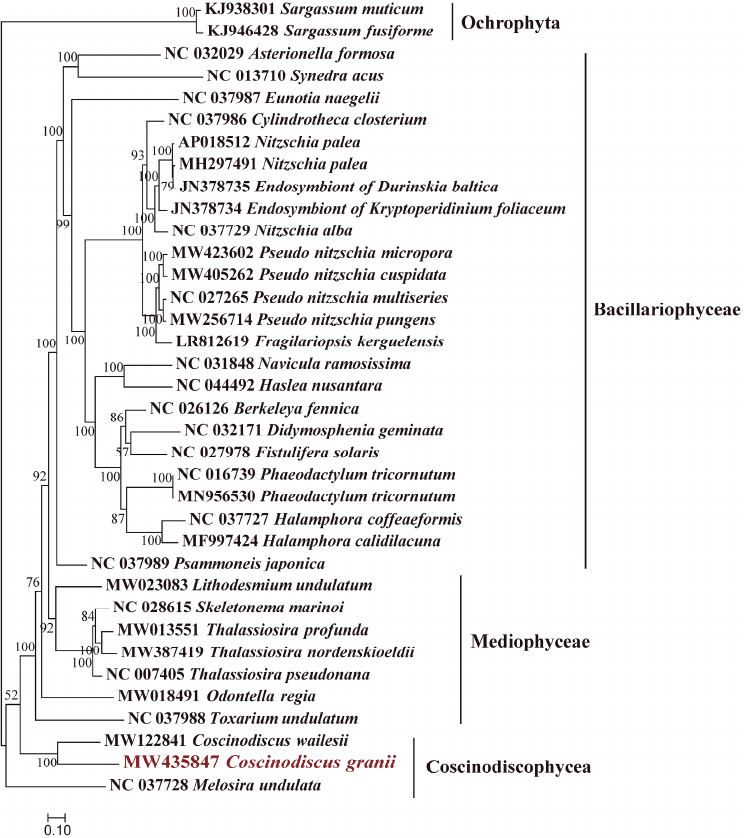
Figure 5. Phylogenetic analysis of C. granii (CNS00554). Maximum likelihood (ML) phylogenetic tree using concatenated amino acid sequences of 27 common protein-coding genes from 34 publicly diatom mtDNAs, and Sargassum fusiforme (KJ946428) and Sargassum muticum (KJ938301) in Ochrophyta were used as out-group taxa. The numbers beside branch nodes are the percentage of 1000 bootstrap values.